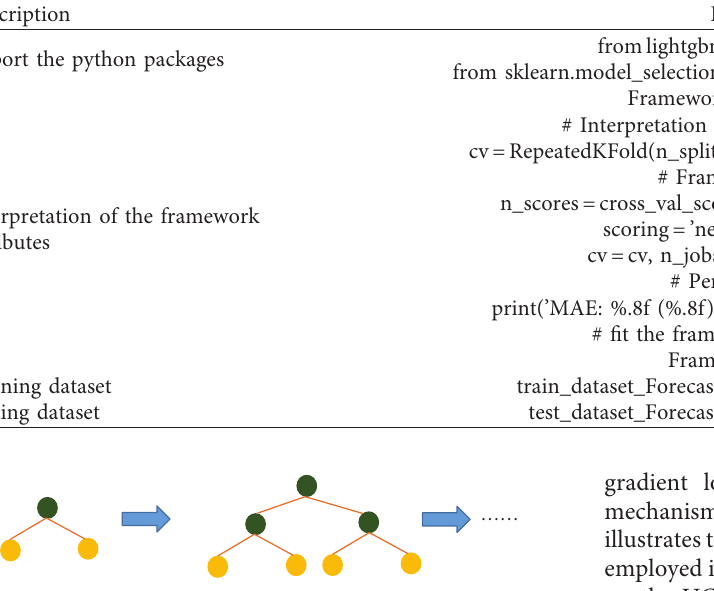
Figure 8: Description of XGBoost employed in this